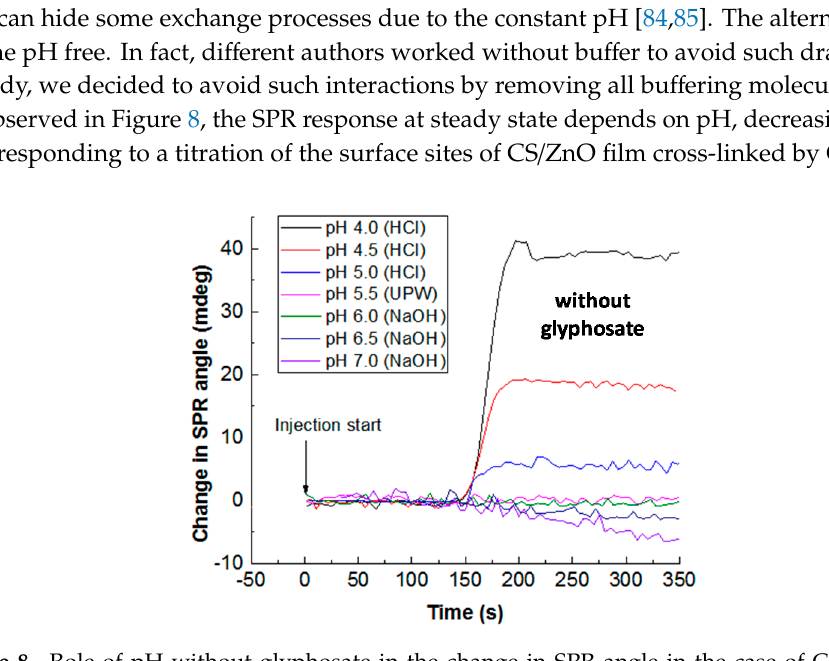
Figure 8. Role of pH without glyphosate in the change in SPR angle in the case of CS/ZnO film cross-linked by GA (dead time corresponds to around 156 s between injection and the cell output). Experimental conditions for each reported pH value: injection of UPW (pH 5.5) before injection of a solution at a given pH adjusted by 0.01 M HCl and 0.01 M NaOH into the SPR